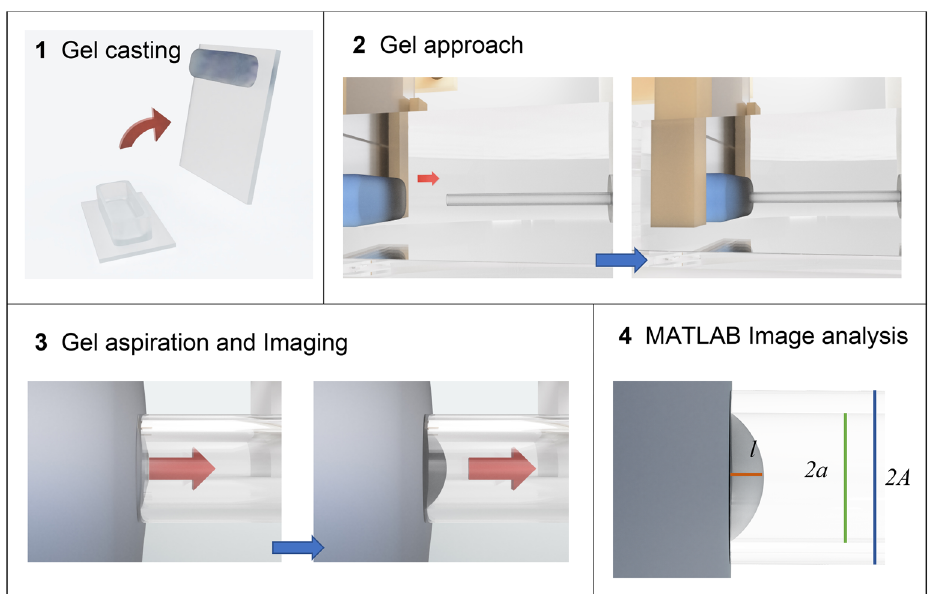
Figure 5. Workflow of the macroindentation process. 1. Preparation of the gel inside a PDMS ring 2. The gel approaches the micropipette cross section until contact is reached and pressure is applied 3. The image is captured with an inverted microscope 4. and analyzed to determine the internal radius a and the aspiration length l with a MATLAB